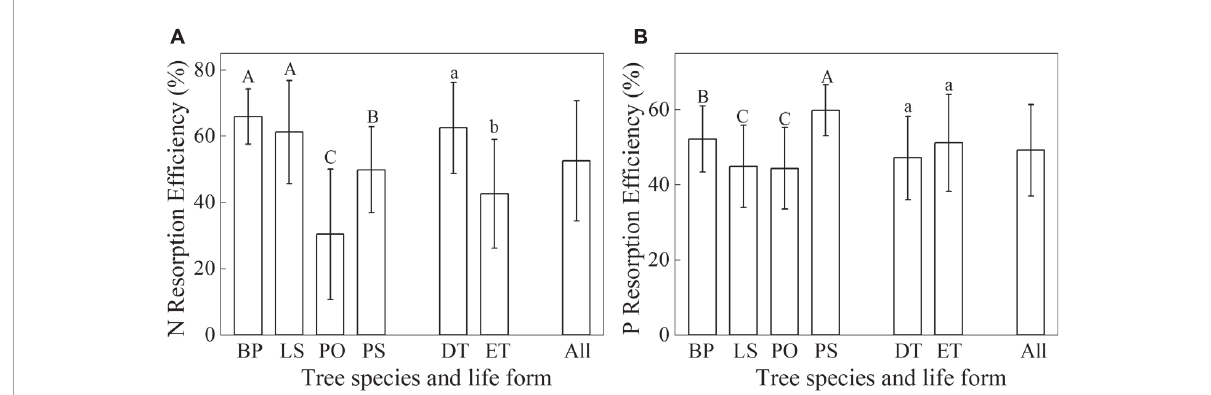
FIGURE3 N (A) and P (B) resorption efficiencies of four tree species and different life forms in Kanas Natural Forest. Betula pendula (BP), Picea obovata (PO), Larix sibirica (LS), Pinus sibirica (PS), deciduous trees (DT), and evergreen trees (ET). Different capital and lowercase letters represent significant differences between different tree species and life forms, respectively ( p < 0.05).